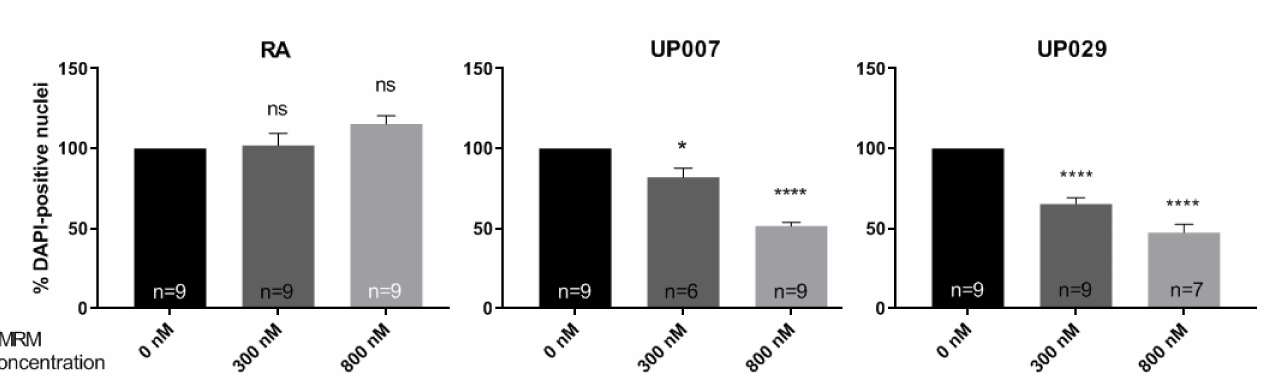
Figure 6. Delayed photoactivation of TMRM enables selective effect on GBM cells. Cells were loaded with TMRM, 300 nM or 800 nM which was then removed from the media. Twenty-four hours later, light was applied for 30 s (1.4 mW/mm 2 ). When counted 3 days later, the number of remaining GBM but not RA was strongly decreased. This specificity was achieved by preferential retention of TMRM in GBM cells. N is the total number of datapoints from 3 independent experiments. (*) p value < 0.05, (****) p value < 0.0001. ns—not